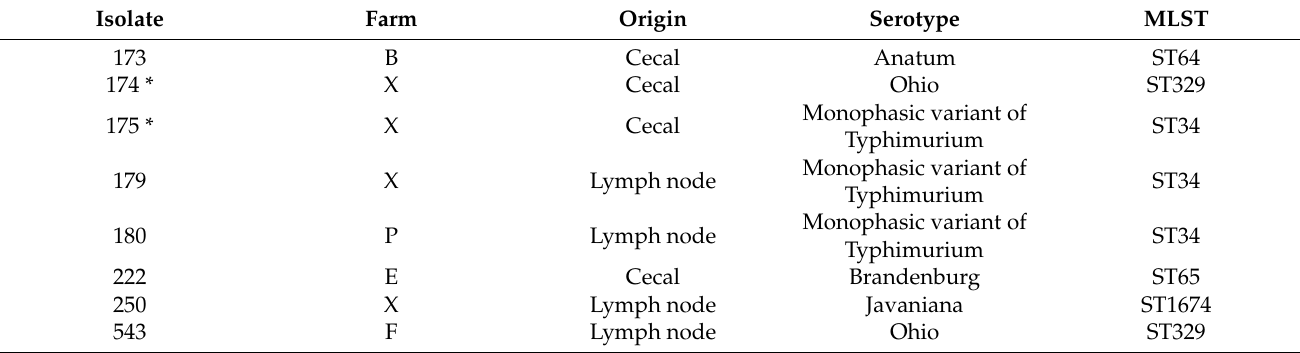
Table 1. Isolation and serotype results and origin of the